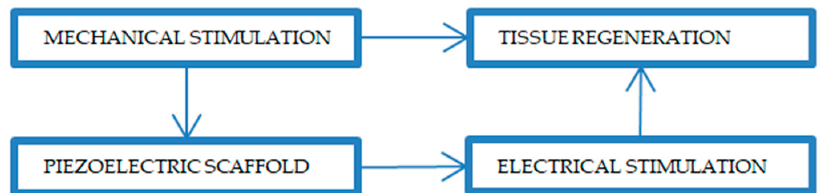
Figure 5. Representative scheme of tissue regeneration in response to the mechanical and electrical stimulation on the piezoelectric scaffold.